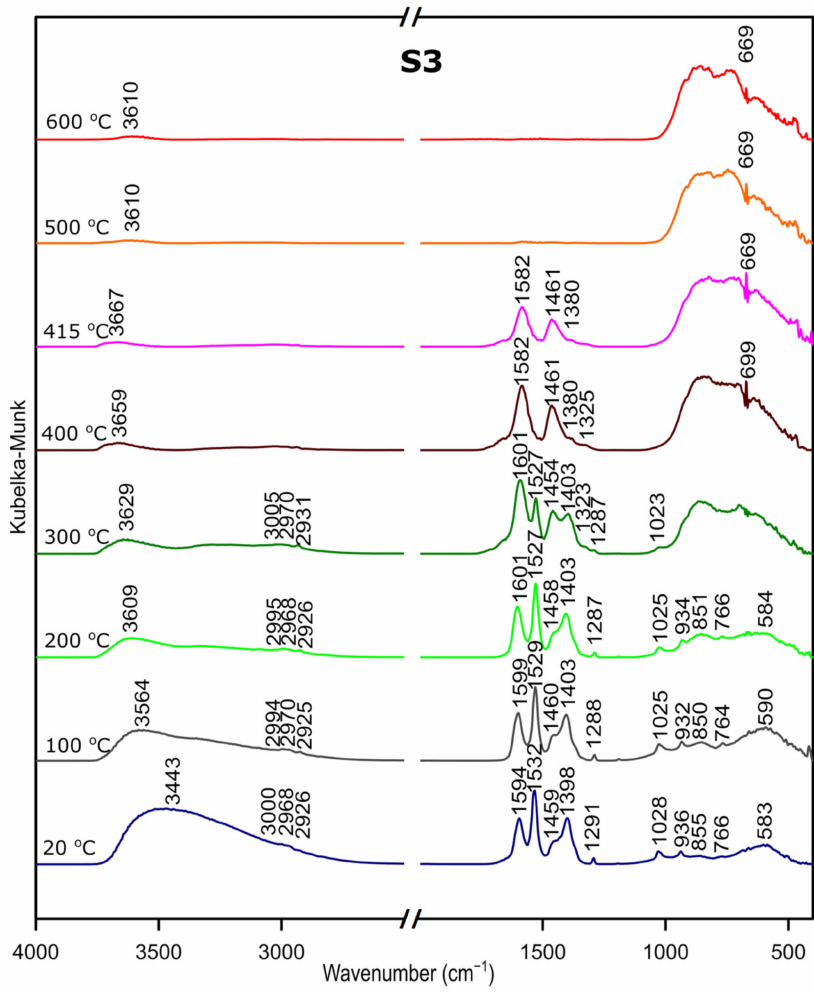
Figure 7. DRIFTS results for the sample